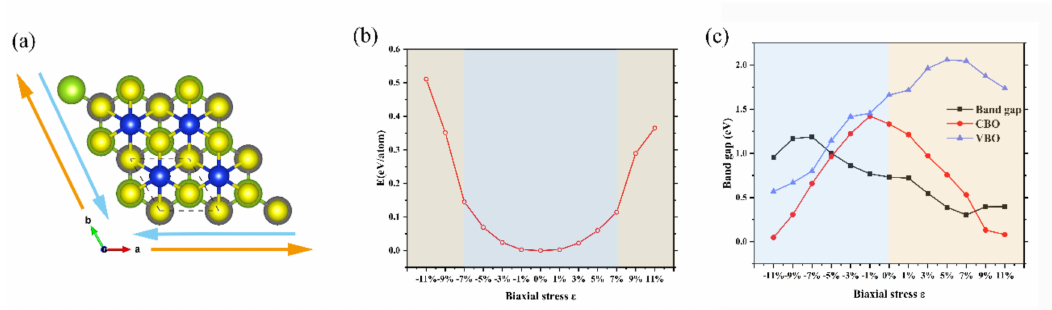
Figure 4. ( a ) Schematic diagram of tensile (orange arrows) and compressive (blue arrows) stresses on the SiS 2 / WSe 2 hetero-bilayer. ( b ) Strain energy ( E ) as a function of strain of the biaxial stress ε . ( c ) Band gap and band o ff sets of the SiS 2 / WSe 2 hetero-bilayer as a function of the biaxial stress ε .